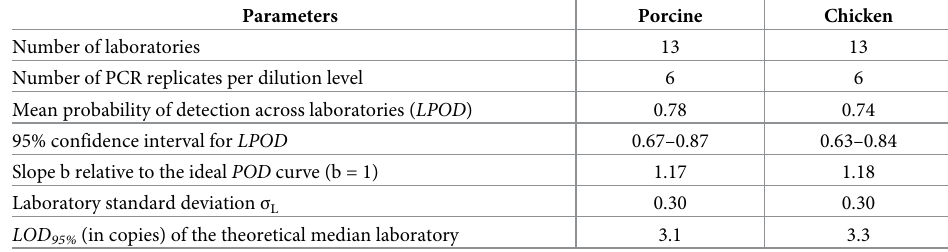
Table 6. Summary of collaborative trial results for the POD